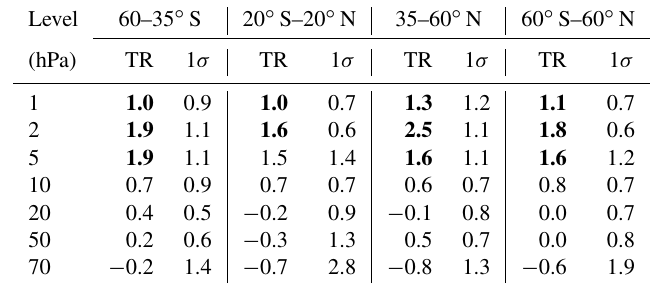
Table 6. Average 2000 to 2016 ozone profile trends, obtained from individual trends for the GOZCARDS, SWOOSH, SAGE–OSIRIS, 1 σ of the individual trends, in percent per decade. Bold numbers indicate average trends TR larger than 2 σ/ significant values with 95% confidence, assuming that the seven data sets give three independent realizations of individual trends TR (i) . The SBUV-NASA and SBUV-NOAA data sets are used only at levels above 40hPa (23km). Therefore, 2 σ/ for boldface at the 50 and 70hPa